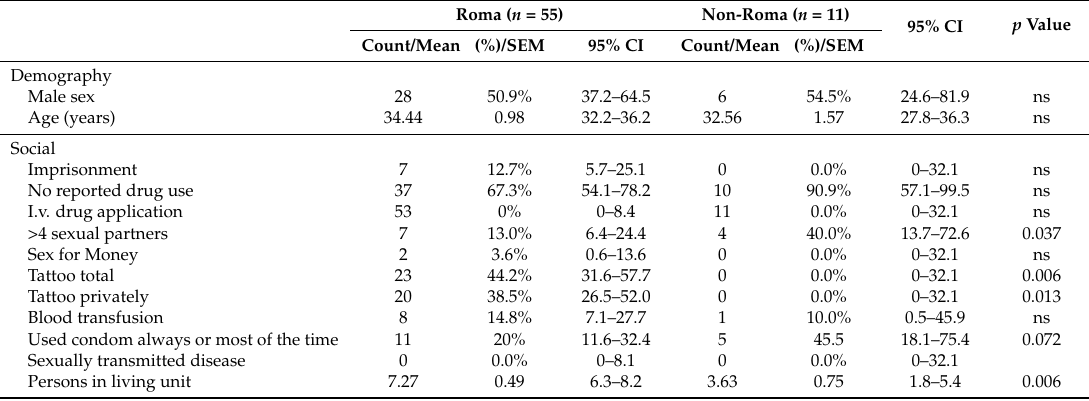
Table 3. Comparison of risk factors between HBsAg positive Roma and non-Roma